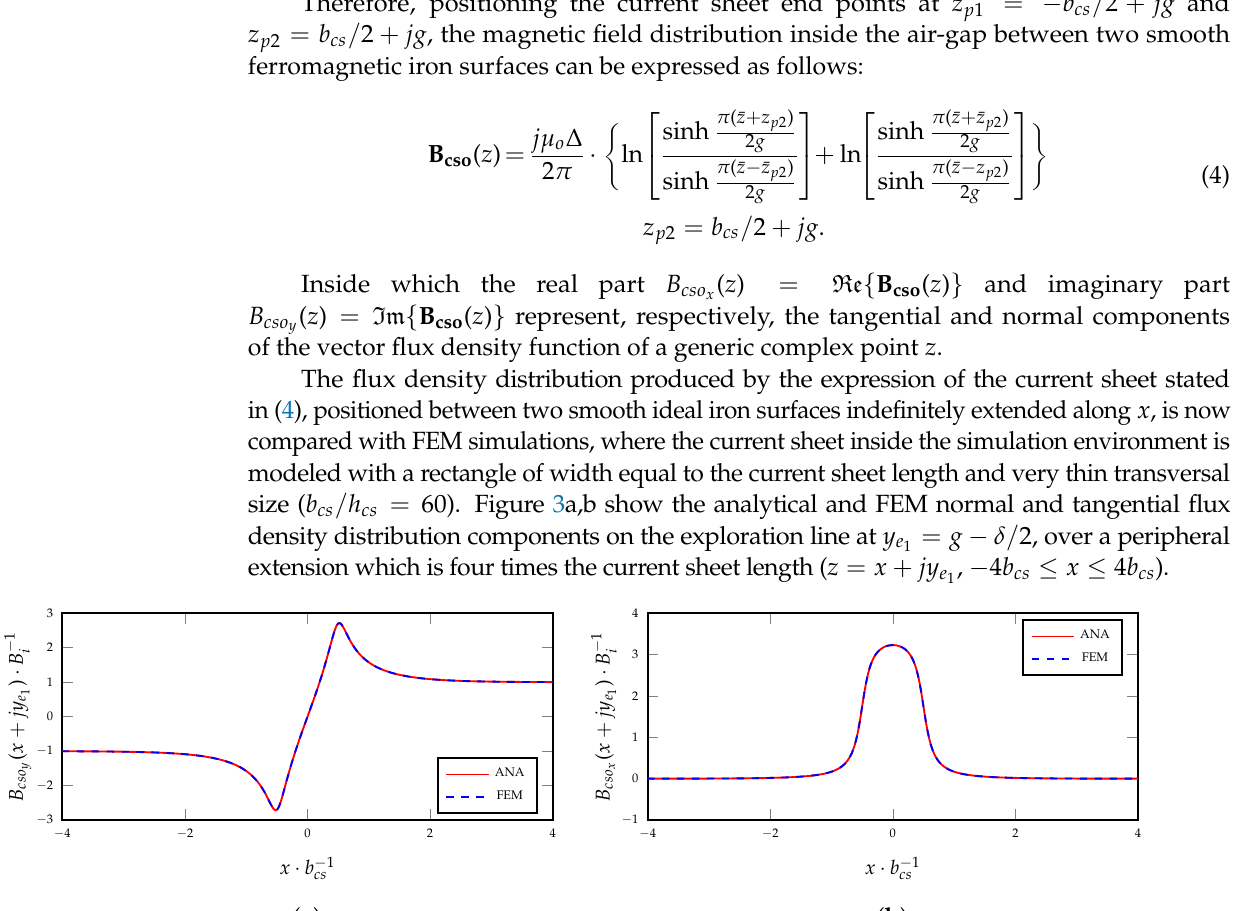
Figure 3. Analytical and FEM flux density distributions, on the exploration line y e by a horizontal current sheet of length b cs set between two smooth iron surfaces ( − 4 b cs ≤ x ≤ 4 b cs N x = 1000, g = 11.5 mm, δ = 1.5 mm). ( a ) p.u. normal component; ( b ) p.u. tangential